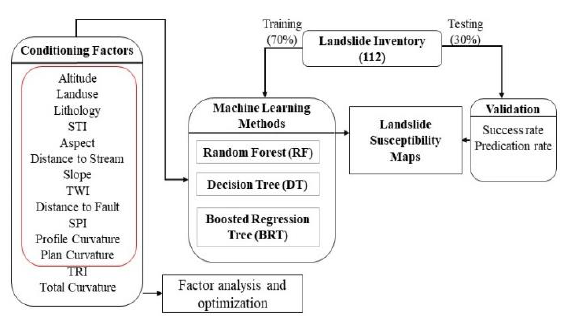
Figure 2. Overall workflow of this